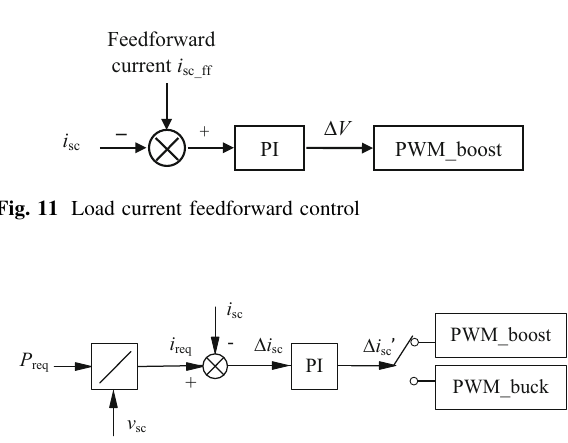
Fig. 12 Power loop control